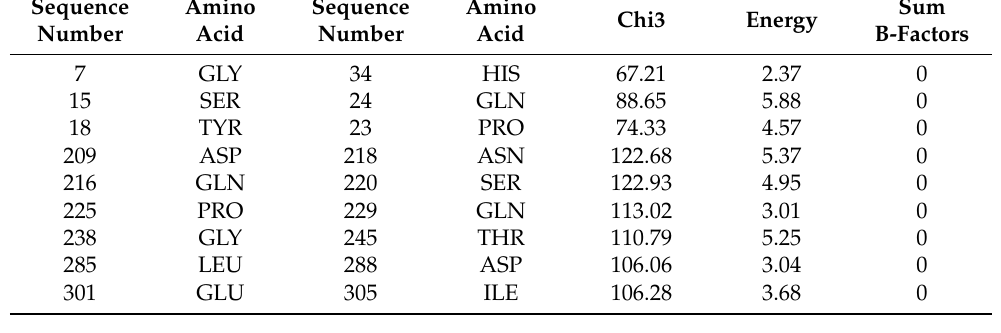
Table 6. List of residues replaced by cysteine.